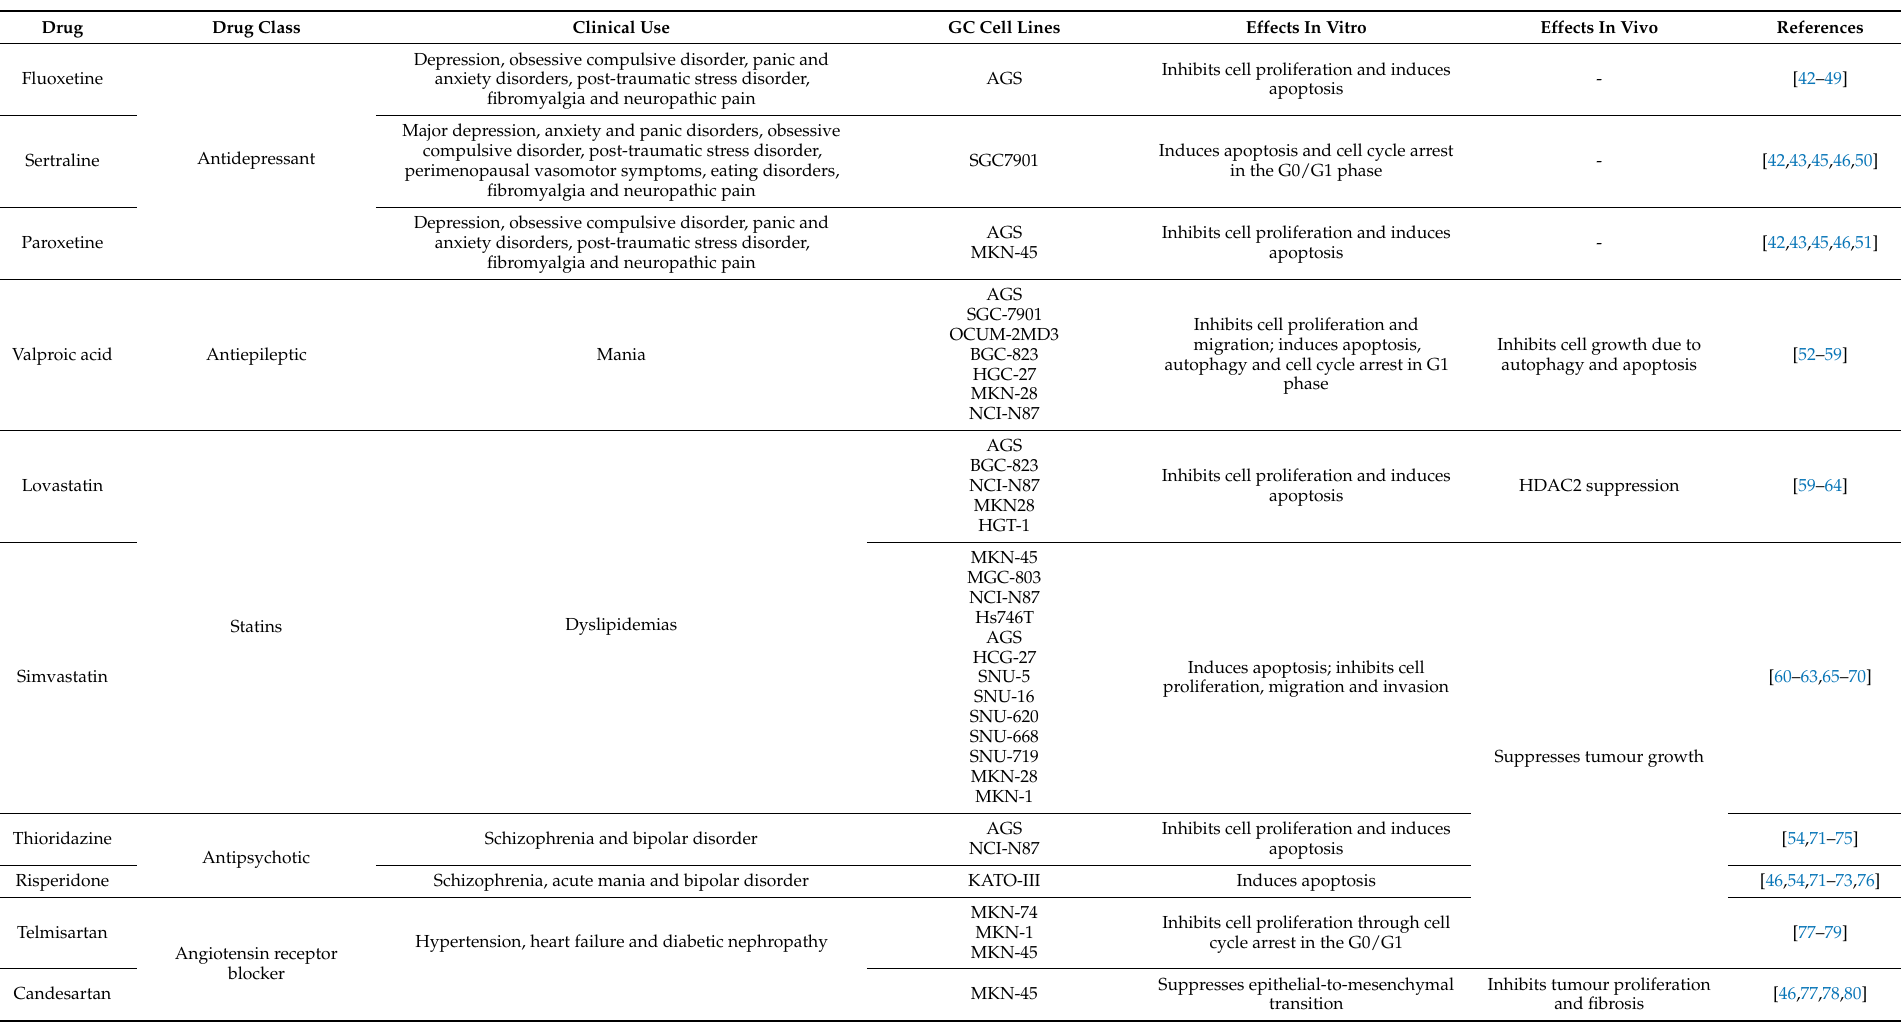
Table 1. Repurposed drugs for gastric